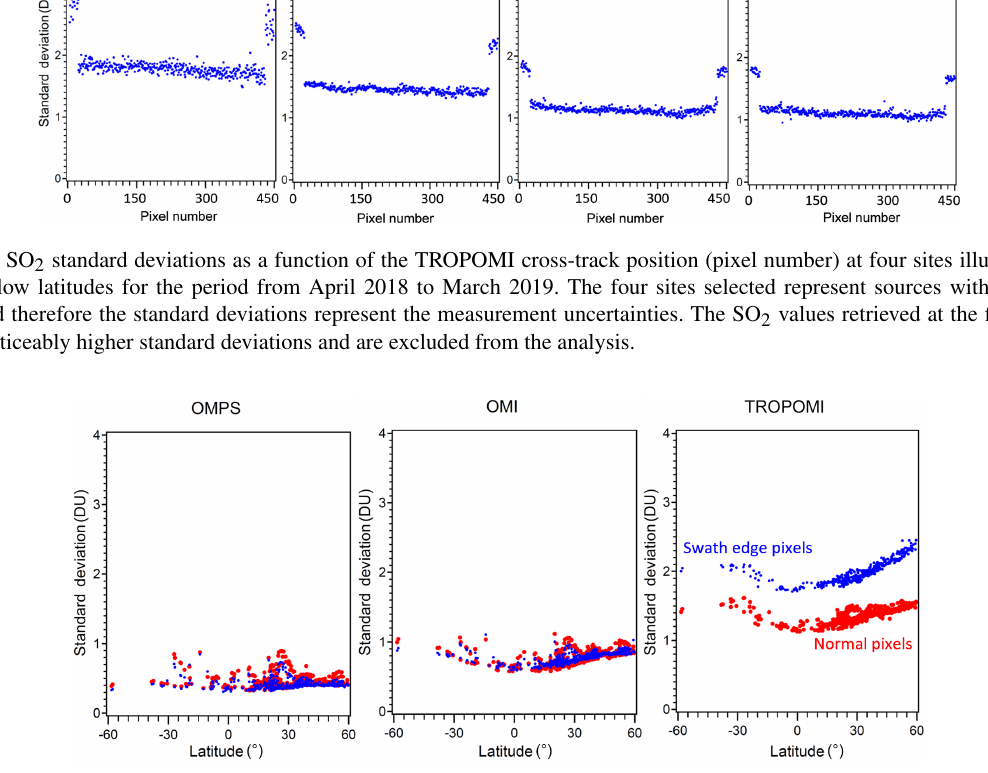
Figure 2. The OMPS, OMI, and TROPOMI SO 2 standard deviation vs. latitude for “normal” (red) and “swath edge” (blue) pixels. Swath edge pixels were defined as the first and the last 3, 5, and 20 pixels for OMPS, OMI, and TROPOMI, respectively. All other pixels were considered normal. The plot is based on satellite measurements centred between 150 and 300km around the sources from the catalogue. The sources under the South Atlantic Anomaly (SAA) are